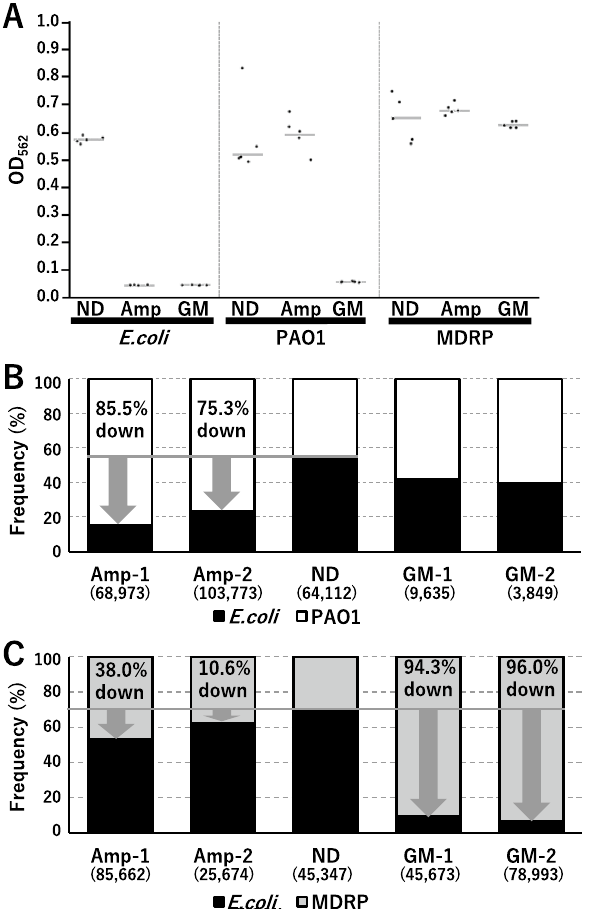
Figure 1. Comparison of bacterial compositions by nanopore DNA sequencing. ( A ) Results of AST by batch test. The gray lines represent the average OD values. ( B ) Identification of bacterial compositions by the nanopore DNA sequencer MinION using bacterial mixtures of E. coli (black) and PAO1 (white) and ( C ) E. coli (black) and MDRP (gray). The number inside the parentheses is the number of reads. The gray line shows frequency of E. coli in untreated bacterial mixture. The arrows show the VBD indeces. The VBD index is the estimated rate of decrease of the number of viable bacteria by the effect of antibiotics. ND untreated bacterial mixture; Amp ampicillin treatment; GM gentamicin